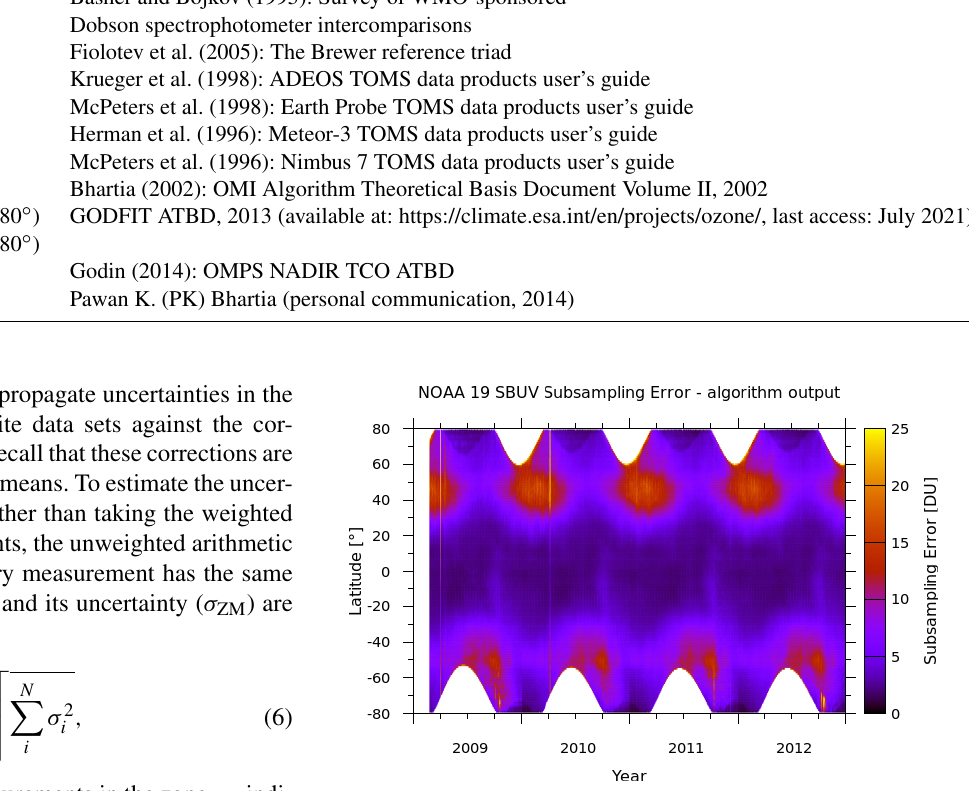
Figure 4. The additional uncertainty introduced to the SBUV zonal means as a result of undersampling the zonal TCO profile. Regions shaded in white denote the polar night where space-based measure- ments in the UV–visible part of the spectrum are not